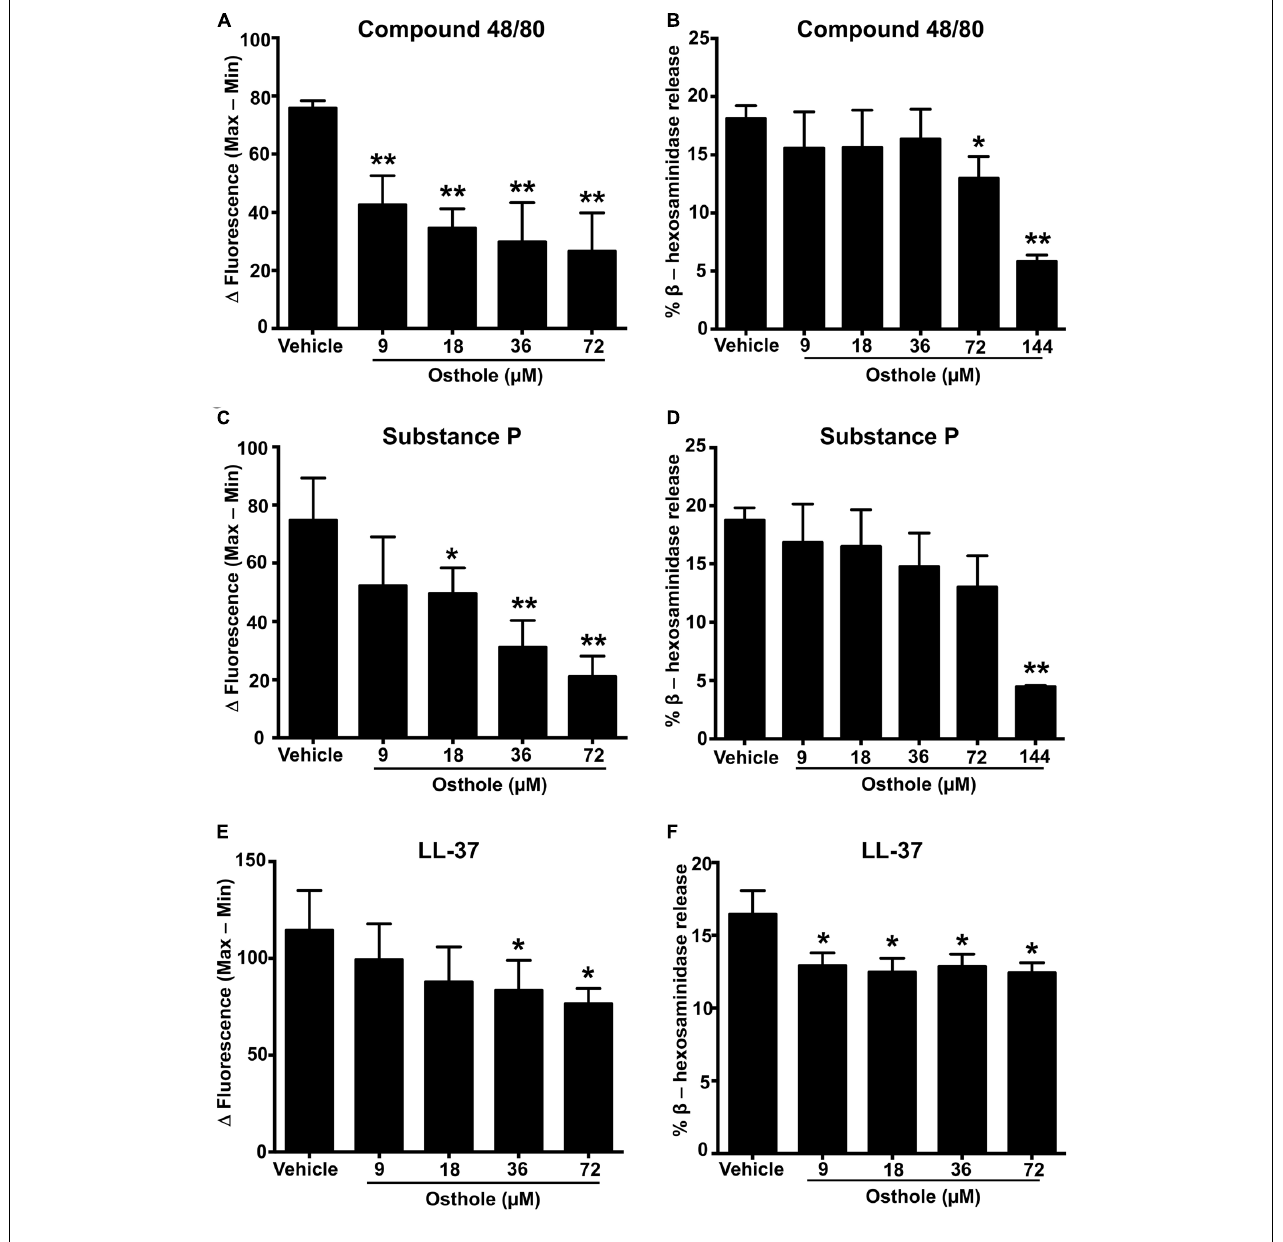
FIGURE 2 | Ca 2 + mobilization and degranulation induced by MRGPRX2 ligands is reduced by osthole in RBL-2H3 cells stably expressing MRGPRX2. RBL-2H3 cells stably expressing the MRGPRX2 receptor were treated with vehicle (0.2% DMSO in PBS) or osthole (indicated concentrations) for 30 min. (A,C,E) Ca 2 + mobilization and (B,D,F) degranulation assays were performed following incubation with (A,B) compound 48/80 (100 ng/ml), (C,D) substance P (300 nM) or (E,F) LL-37 (3 µ M). Results shown are mean ± SE of three independent experiments. Statistical significance was determined by unpaired Student’s t -test and values from the osthole-treated group was compared with the control vehicle group * p < 0.05 and ** p <